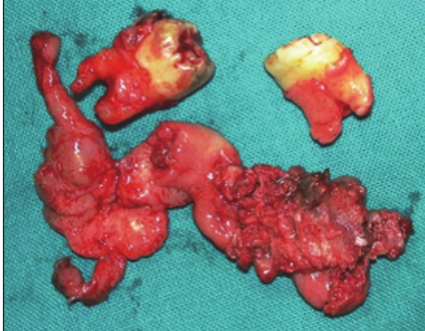
Figure 2: Excised specimen showing proliferative cystic lining and extracted 26 and 27.